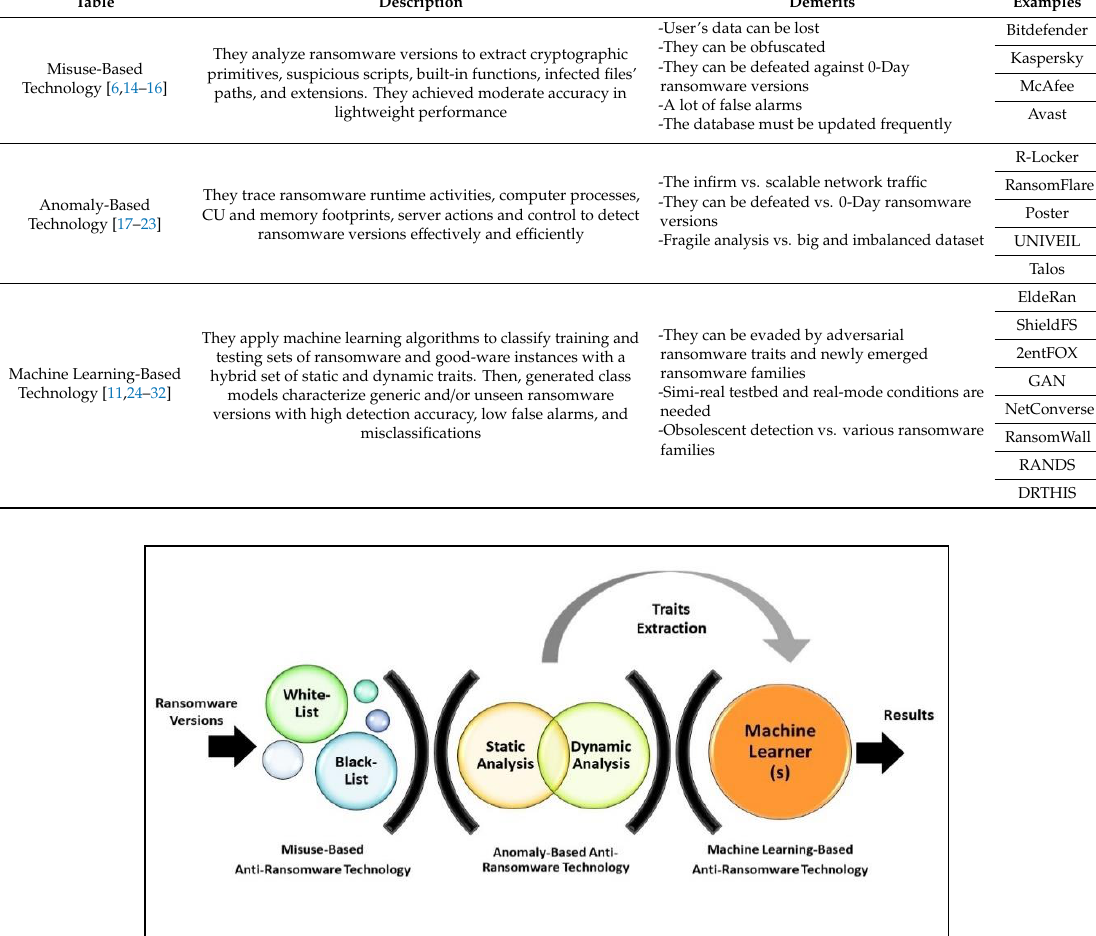
Table 2. Brief description of the state-of-the-art anti-ransomware technology. Table